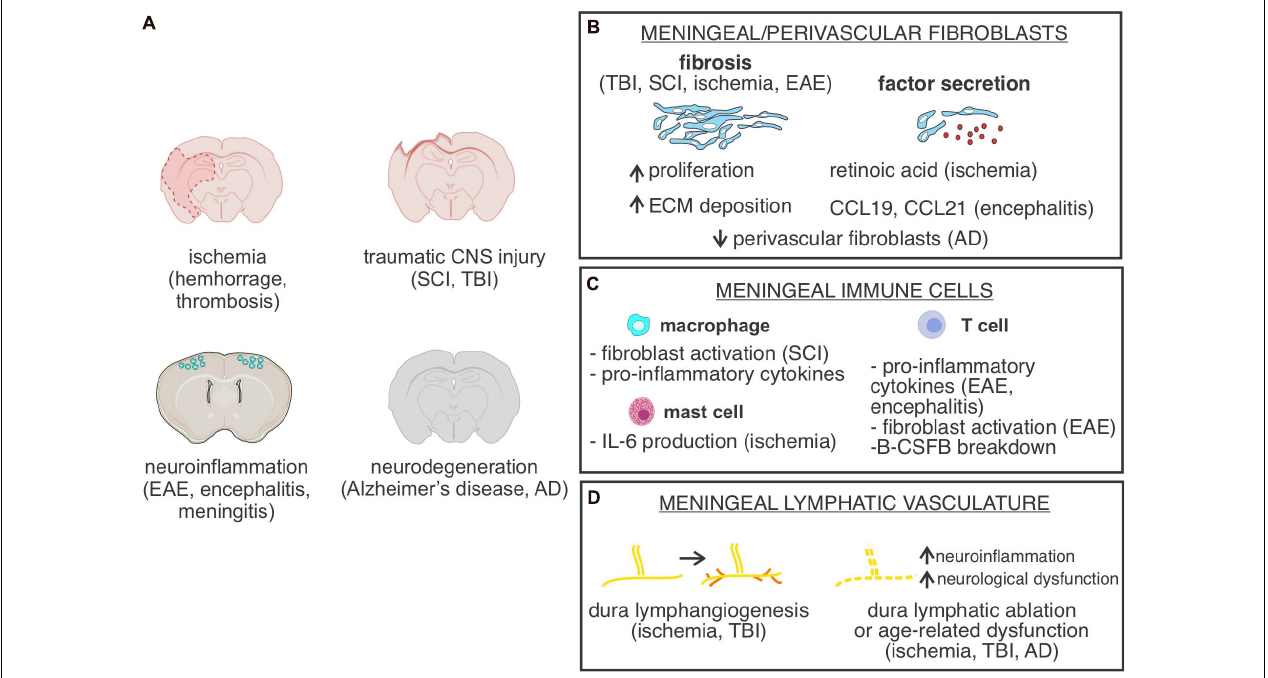
FIGURE 3 | Meningeal cells or structures in CNS injury and disease. (A) Depiction of CNS injury or diseases in which meningeal cells, meninges located cell types or parenchyma located perivascular fibroblasts are part of the pathology. SCI, spinal cord injury; TBI, traumatic brain injury; EAE, experimental autoimmune encephalomyelitis. (B) Graphical depiction of fibrosis, caused by increased meningeal/perivascular fibroblast proliferation and Extracellular matrix (ECM) deposition and summary of known CNS fibroblast-derived factors identified in specific CNS disease states. AD, Alzheimer’s disease. (C) Summary of functional roles of meningeal-located immune cells in specific CNS disease states. B-CSFB, blood-CSF barrier. (D) Summary of cellular changes in meninges located lymphatic vasculature in response to different CNS injuries and disease